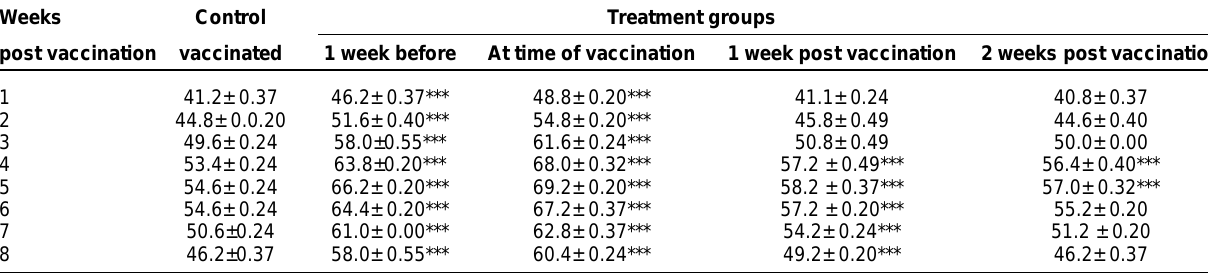
Table-1. Effect of a single intramuscular injection of Imidocarb dipropionate (3mg/Kg b.wt.) on the erythrocyte rosette % in blood of calves vaccinated with FMD vaccine (±S.D, n=5). Weeks